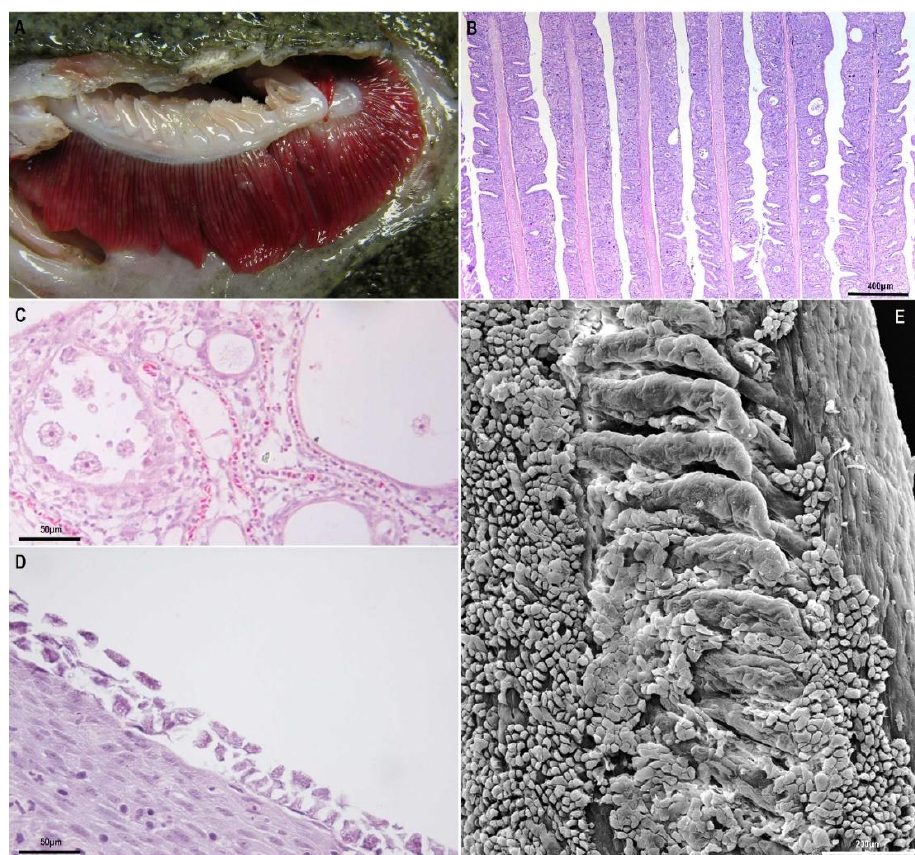
Figure 1. Gills affected by amoebic gill disease (AGD) and nodular gill disease (NGD): ( A ), gill filaments of turbot affected by amoebic gill disease. Note the typical white multifocal lesions. ( B – D ), Paraffin-embedded histological sections: ( B ), extensive hyperplasia of epithelial gill cells in Atlantic salmon, with synechiae and lacunae between filaments; ( C ), detail of amoebae within lacunae between gill filaments in AGD in Atlantic salmon; ( D ), flattened amoebae attached to the surface of proliferative gill lesions of NGD in rainbow trout; ( E ), transmission electron micrographs of gill with amoebae attached to the epithelium in NGD in rainbow